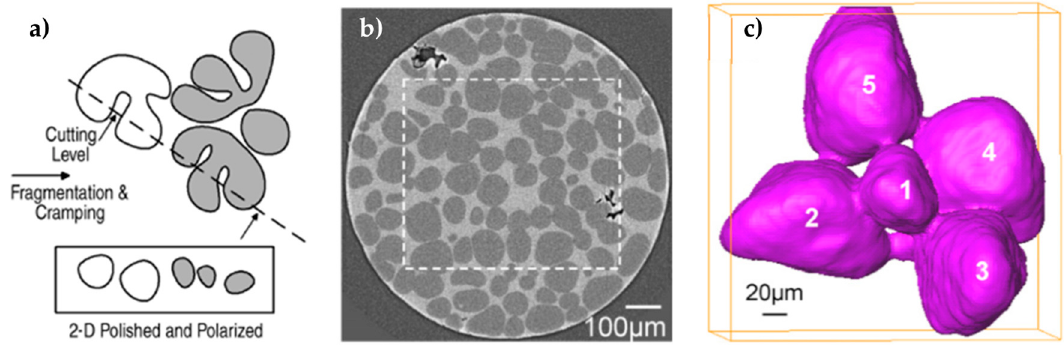
Figure 5. ( a ) Schematic representation of 2D analysis [50], ( b ) 3D image processing with 2D slice, and ( c ) volume representation of the acquired tomography data [51].